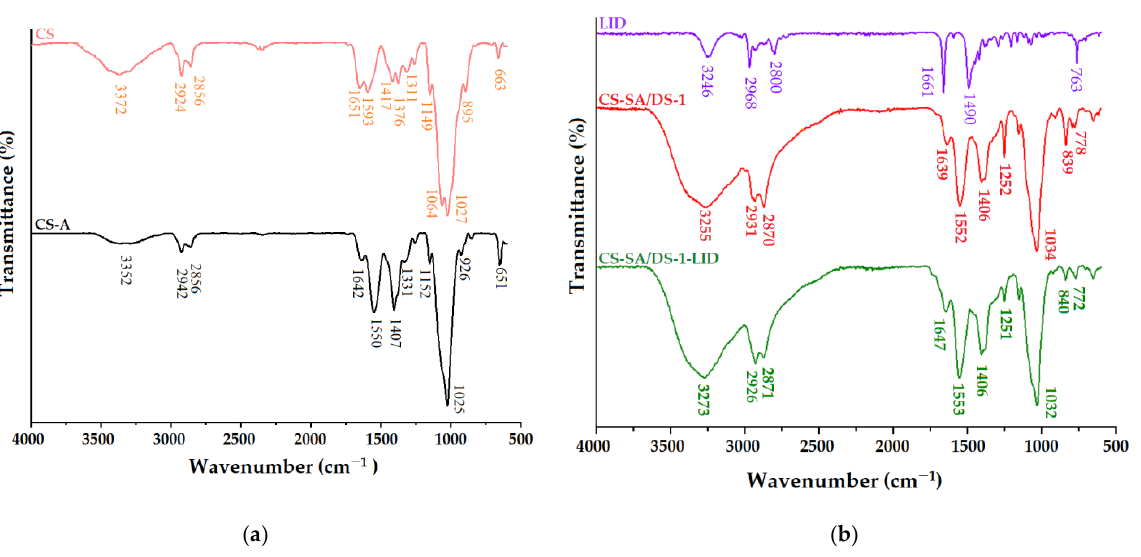
Figure 2. FTIR spectra of: ( a ) pristine chitosan (CS) and chitosan membrane (CS-A), obtained after CS dispersion in 0.5 M acetic acid solution; ( b ) pure lidocaine (LID), non-charged chitosan membrane (CS-SA/DS-1) and lidocaine-charged chitosan membrane (CS-SA/DS-1-LID).